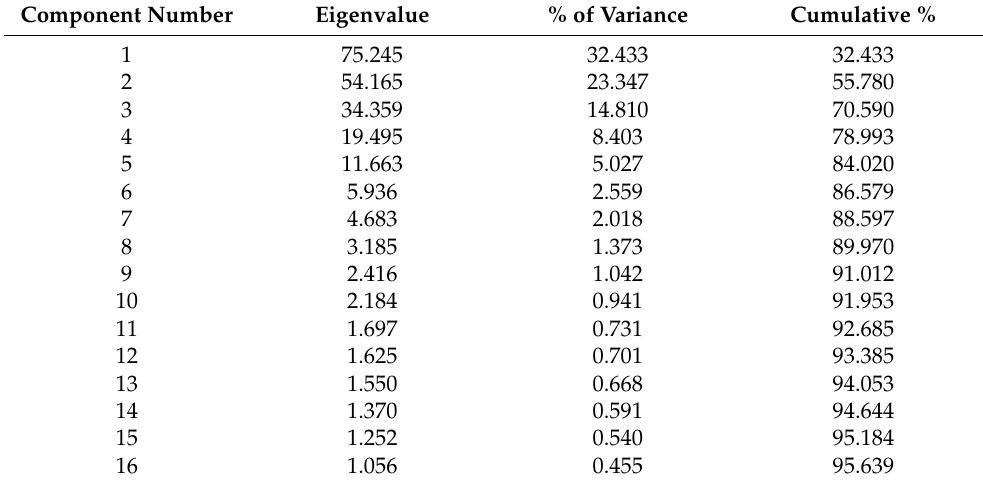
Table 1. Variance of the obtained 16 principal